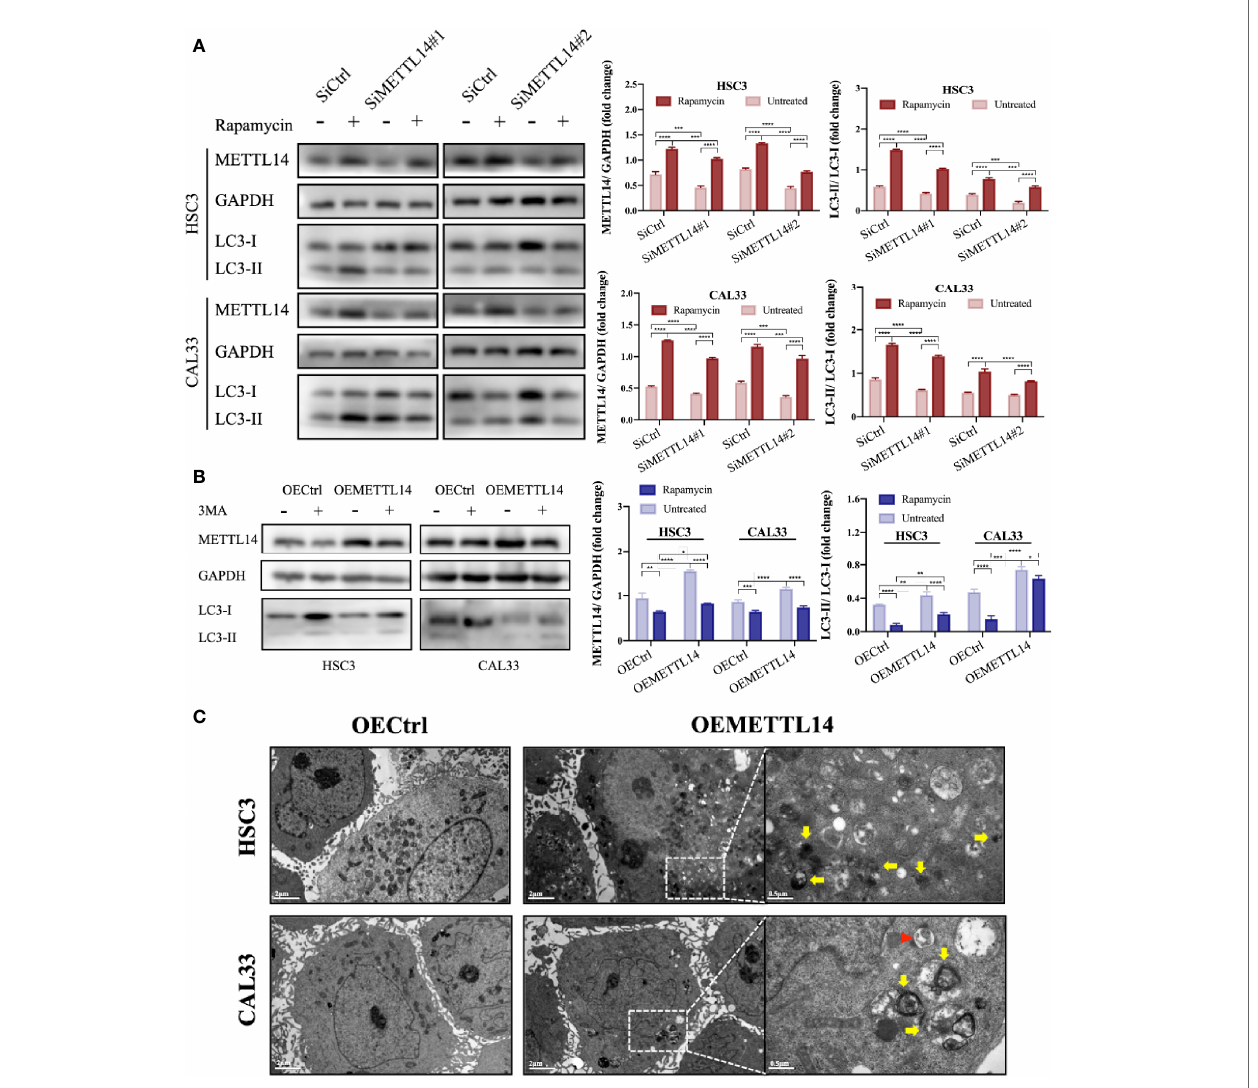
FIGURE 2 | METTL14 promoted autophagy of OSCC cells. (A) METTL14 siRNAs were transiently transfected into HSC3 and CAL33 cells, with or without rapamycin. Western blot was used to detect the expression of METTL14, LC3-I, and LC3-II. (B) Plasmids containing lentiviral oeRNAs of METTL14 were transfected into HSC3 and CAL33 cells, with or without 3MA. Western blot was used to detect the expression of METTL14, LC3-I, and LC3-II. (C) Transmission electron microscopy showed the formation of autophagosomes (red arrows) and autophagolysosomes (yellow arrows) in OSCC cells overexpressing METTL14. ( p or adjusted- p *< 0.05, **< 0.01, ***< 0.001, ****<